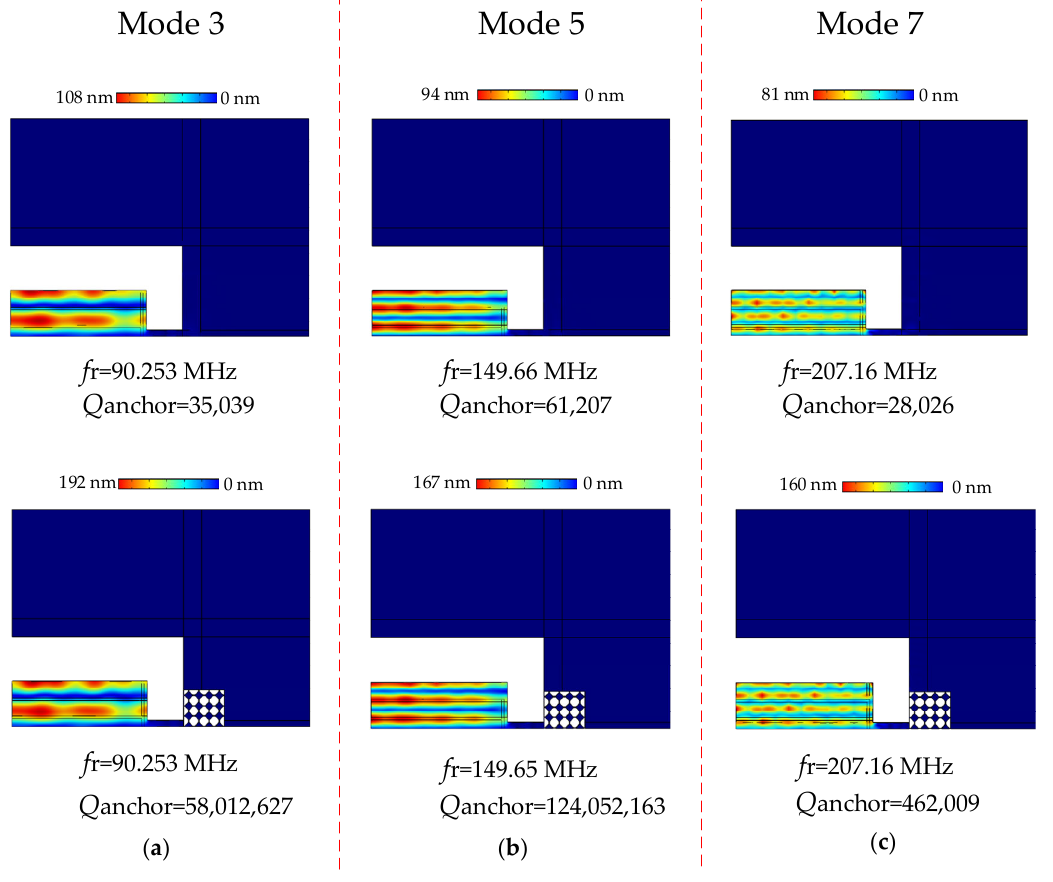
Figure 9. Schematic diagram of total displacement distribution of different MEMS resonators: Finite element simulation of vibration modes and quality factors for the ( a ) third (90.25 MHz, Mode 3), ( b ) fifth (149.66 MHz, Mode 5), and ( c ) seventh (207.16 MHz, Mode 7) overtone resonators of conventional resonators and SCC ‐ PnC resonators.